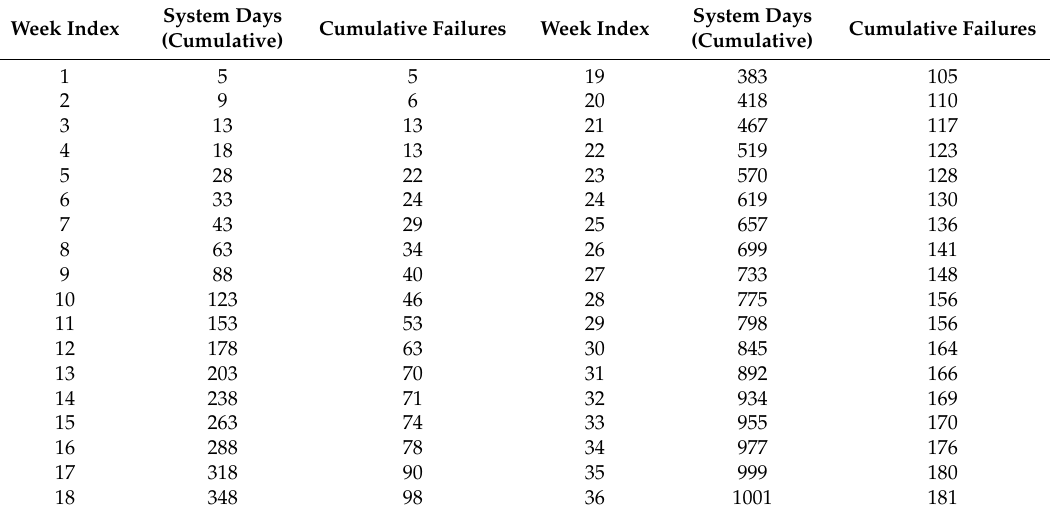
Table 3. Test data for Release 2—Dataset #2.